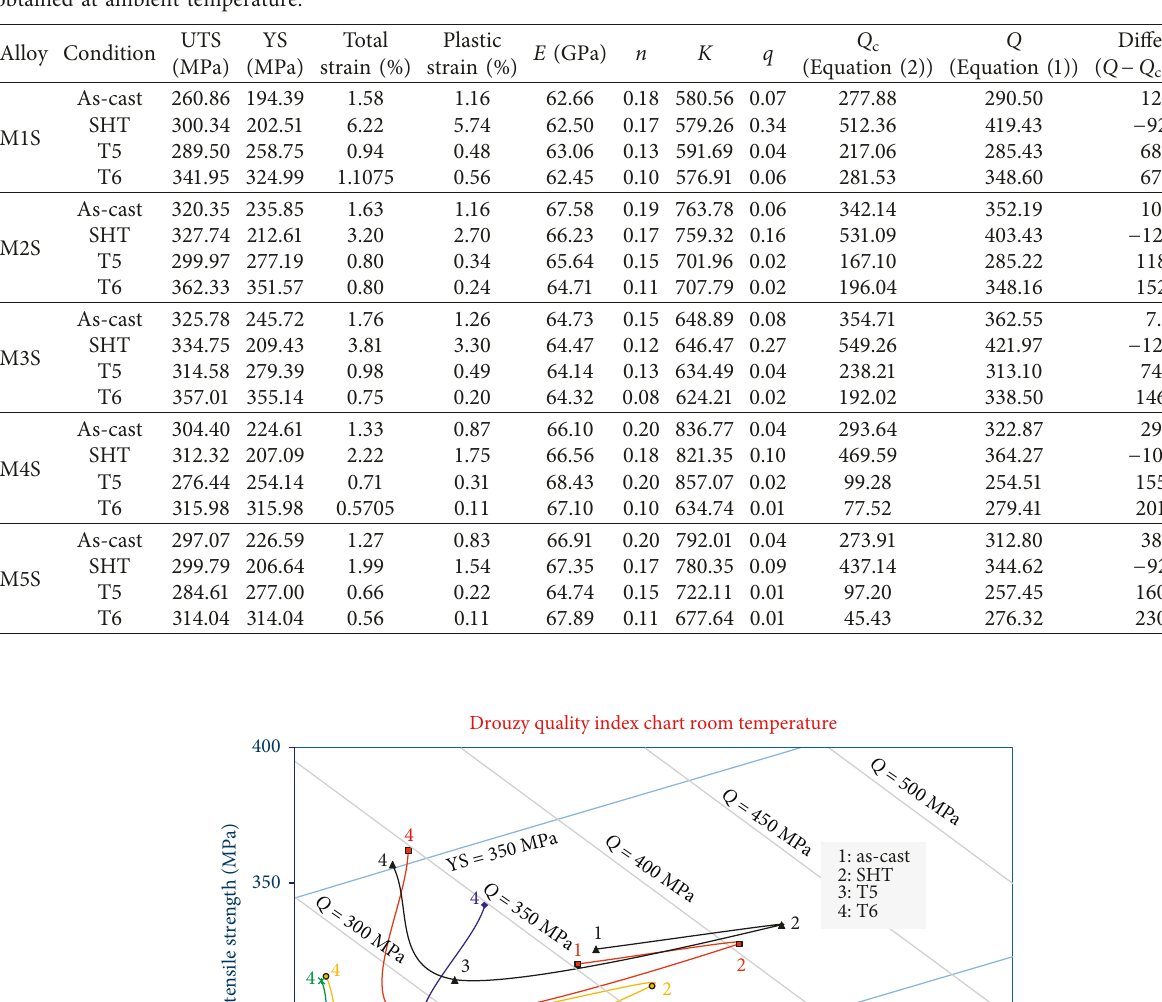
Table 5: Variation in average UTS, YS, % El, Qc, and Q values of the alloys studied in as-cast, SHT, and T5- and T6-treated conditions obtained at ambient temperature.